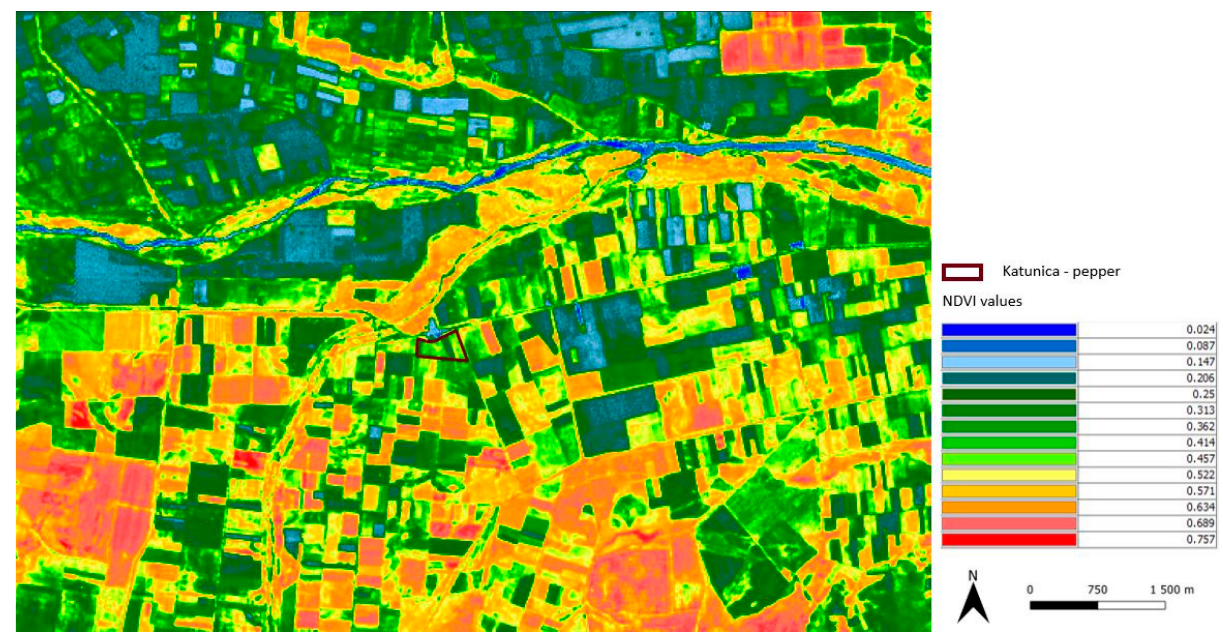
Figure A2. NDVI for Katunica, Bulgaria pepper field retrieved from Sentinel-2 satellite image, GSP 10 m.